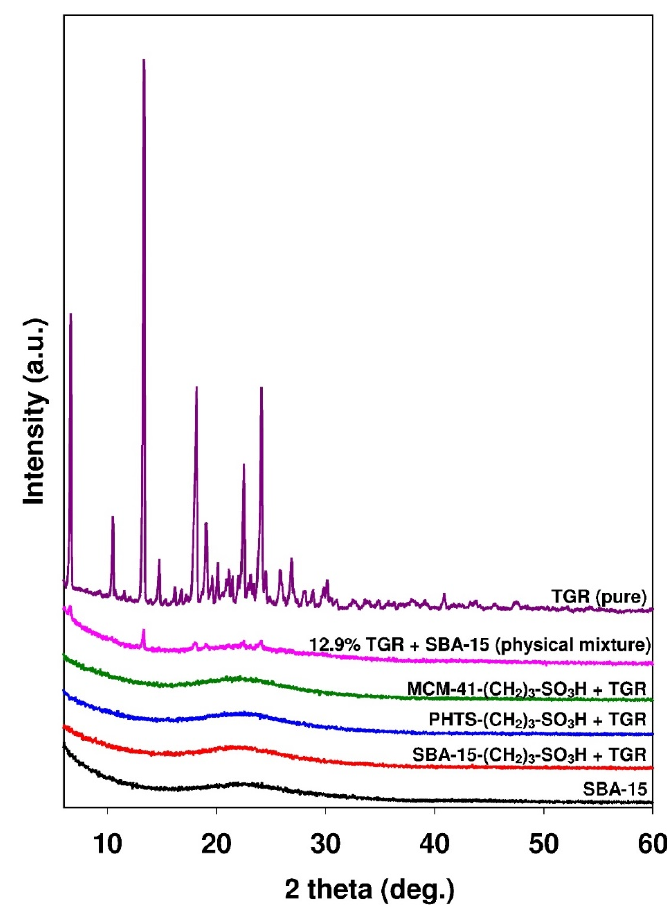
Figure 9. XRD di ff raction patterns (wide-angle) of ticagrelor, physical mixture of ticagrelor with Figure 9. XRD diffraction patterns (wide‐angle) of ticagrelor, physical mixture of ticagrelor with mesoporous silicas and mesoporous silica loaded with ticagrelor. mesoporous silicas and mesoporous silica loaded with ticagrelor. Materials 2020 , 13 , x FOR PEER REVIEW